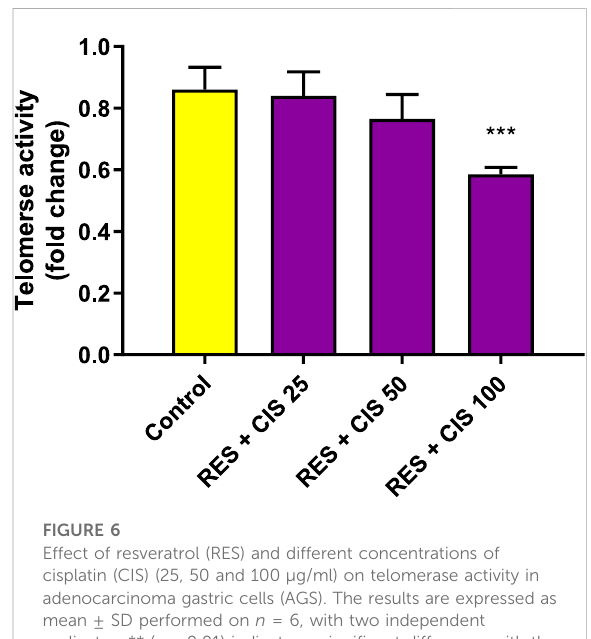
FIGURE 6 Effect of resveratrol (RES) and different concentrations of cisplatin (CIS) (25, 50 and 100 μ g/ml) on telomerase activity in adenocarcinoma gastric cells (AGS). The results are expressed as mean ± SD performed on n = 6, with two independent replicates. ** ( p < 0.01) indicates a signi fi cant difference with the control group.